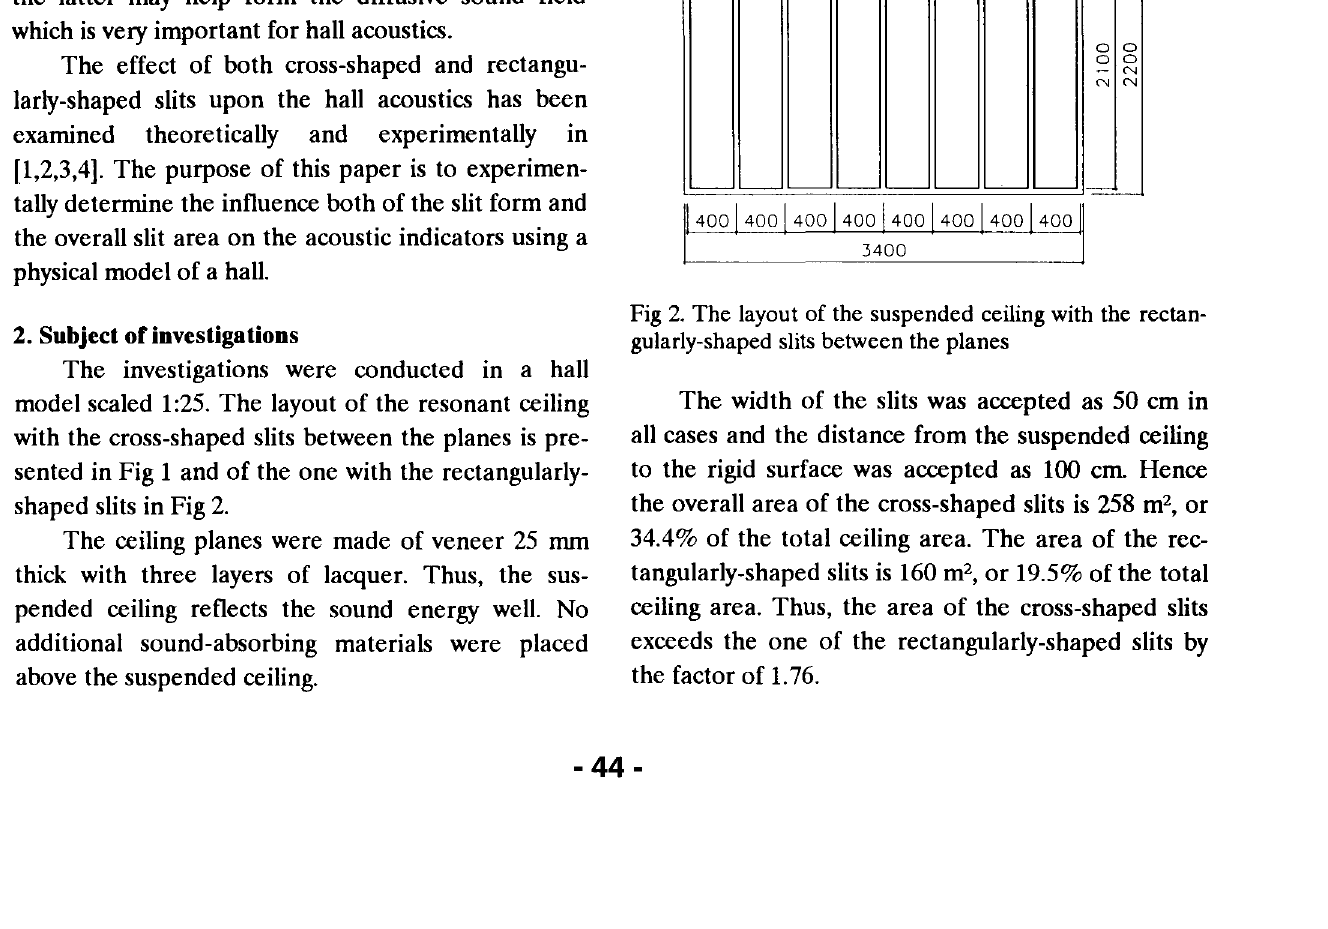
Fig 2. The layout of the suspended ceiling with the rectan gularly-shaped slits between the planes The width of the slits was accepted as 50 em in all cases and the distance from the suspended ceiling to the rigid surface was accepted as 100 em. Hence the overall area of the cross-shaped slits is 258 m 2, or 34.4% of the total ceiling area. The area of the rec tangularly-shaped slits is 160m 2, or 19.5% of the total ceiling area. Thus, the area of the cross-shaped slits exceeds the one of the rectangularly-shaped slits by the factor of 1.